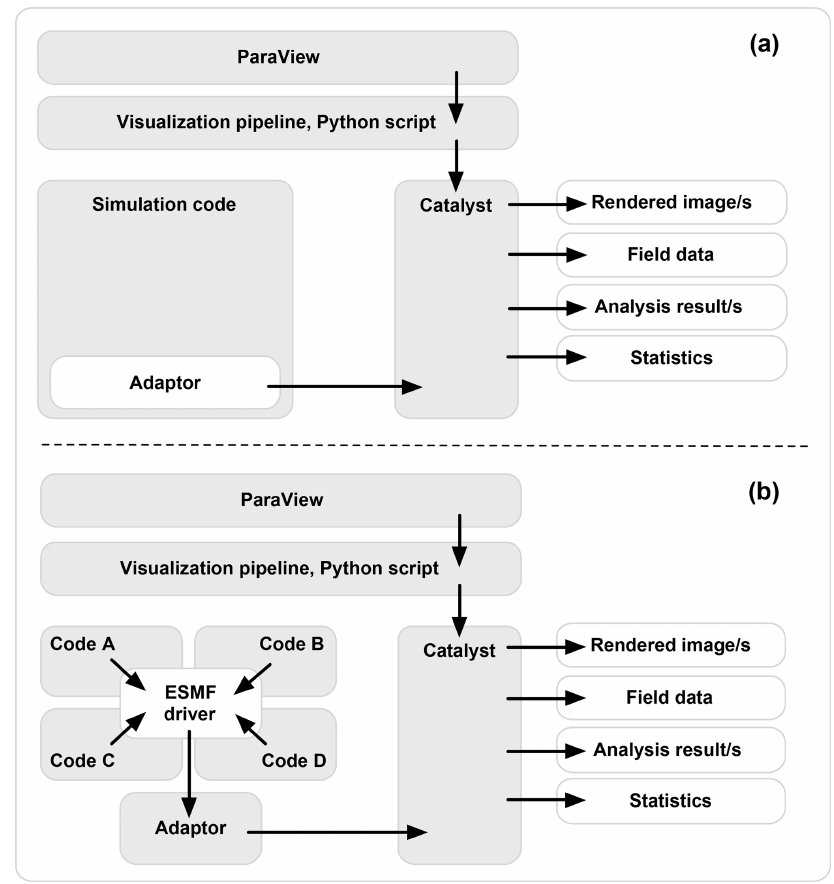
Figure 5. Comparison of the (a) conventional and (b) ESMF-integrated in situ visualization